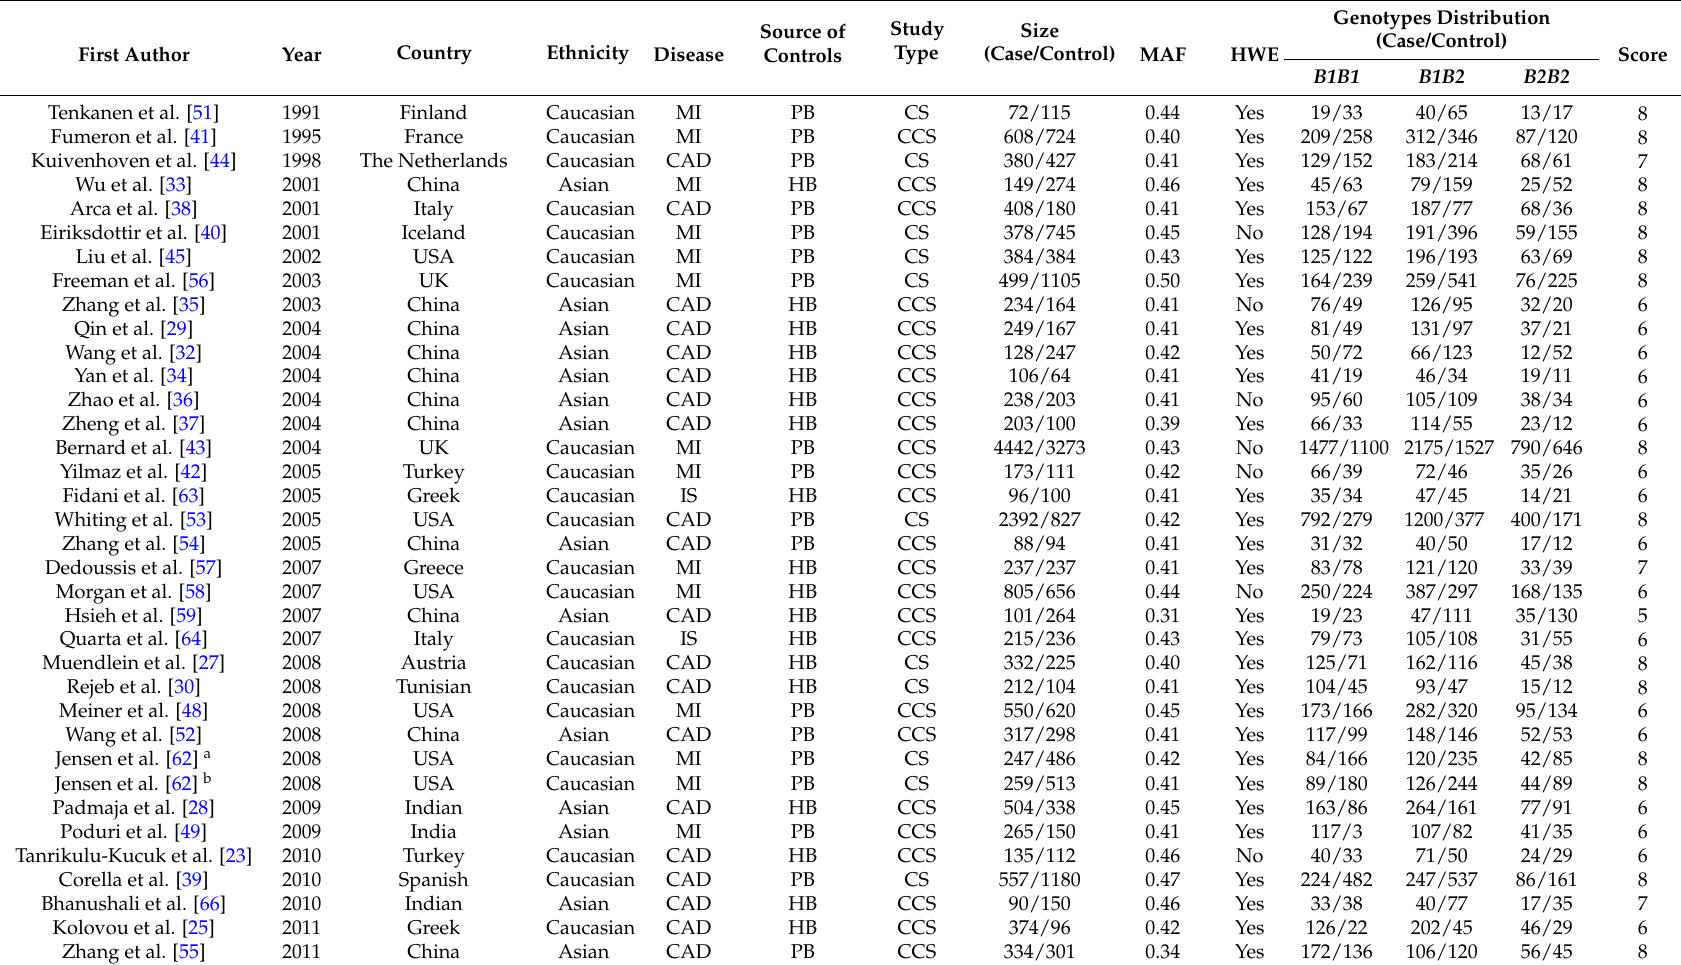
Table 1. Characteristics of individual studies included in the meta-analysis of atherosclerosis and the CETP TaqIB